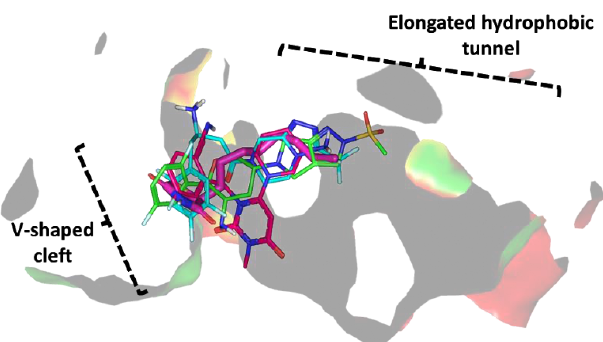
Figure 7. Ligand–protein binding interactions at P. aeruginosa LasI synthase binding site. Predicted binding modes of the docked ligands (cyan or magenta sticks): ( A ) SIT, ( B ) OMR, ( C ) TRG, and ( D ) TZD-C8. Only amino acids located within 5 Å radius distance from the bound ligand are displayed and labeled with sequence numbers. Non-polar hydrogen atoms are hidden for clarity. Hydrogen bonding is depicted as black dashed lines. ( E ) Overlay of investigated compounds (SIT, OMR, and TRG as cyan, green, and purple lines, respectively) and TZD-C8 (magenta sticks) binding to the protein’s canonical binding site comprising V -shaped cleft and elongated hydrophobic tunnel sub-pockets.